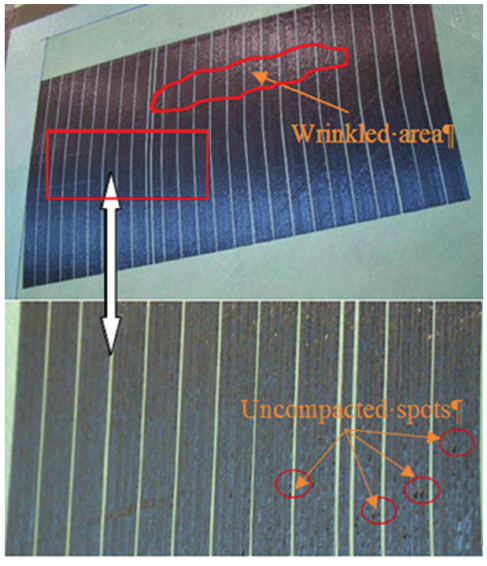
Figure 7 Fiber steering trial case 1, θ = 5 ° , ply 1, laid down at 2 m/min.